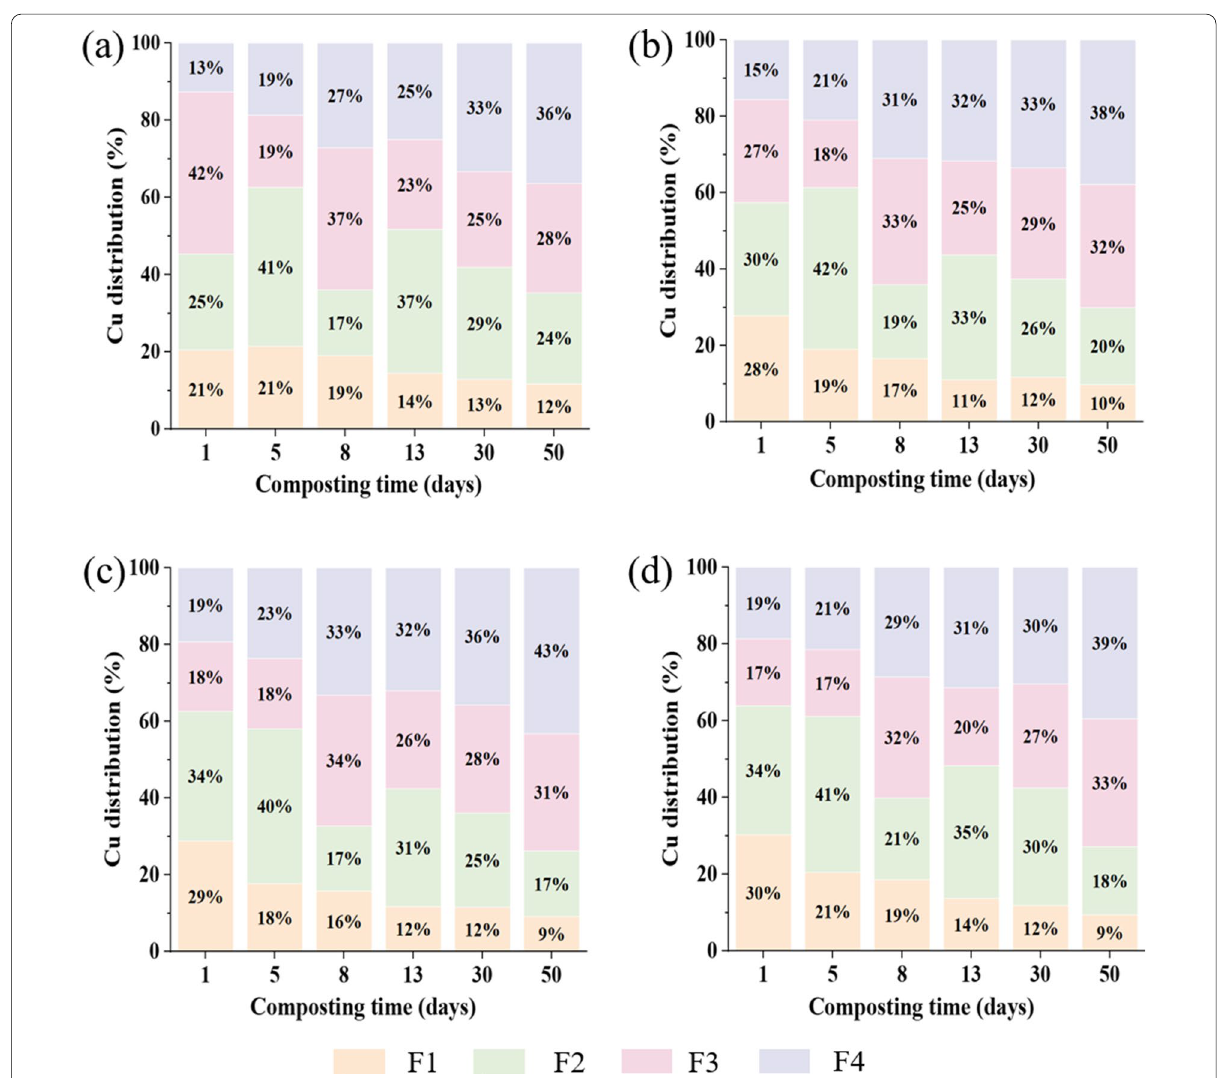
Fig. 2 Changes in Cu speciation distribution proportion of CK ( a ), BC ( b ), MB ( c ) and CB ( d ) composting. F1: acid-soluble fraction; F2: reducible fraction; F3: oxidizable fraction; F4: residual